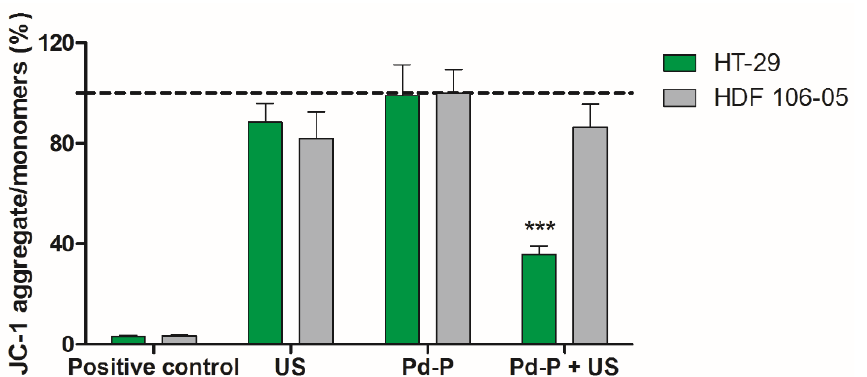
Figure 8. Cell mitochondrial membrane potential after sonodynamic treatment. HT-29 and HDF 106-05 cells were incubated for 24 h with 500 µ M Pd-P and then exposed to US (1.5 W/cm 2 at 1.866 MHz, for 5 min). Mitochondrial membrane potential was evaluated by JC-1 assay immediately after treatment by flow cytometry and expressed as percentage of JC-1 aggregates to monomers fluorescence ratio in each sample. A positive control was obtained by exposing cells to H 2 O 2 (500 µ M) for 3 h. The mitochondrial membrane potential of untreated cells is represented by the dashed line. Statistically significant difference versus untreated cells: *** p <